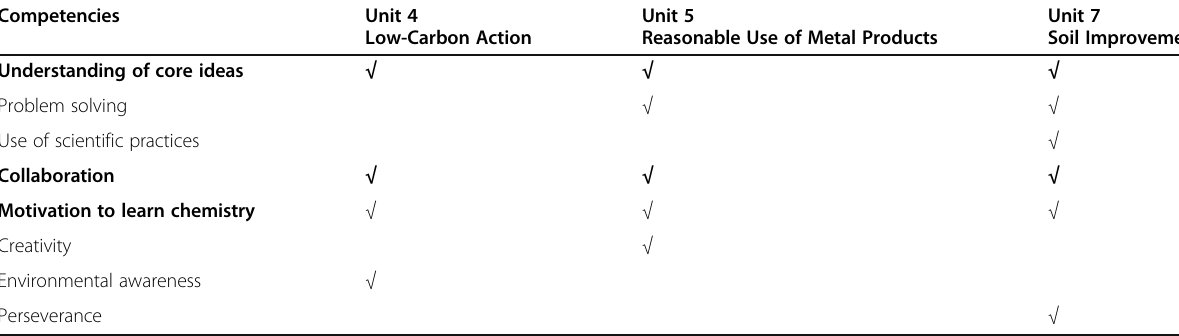
Table 5 Competencies demonstrated in PBL